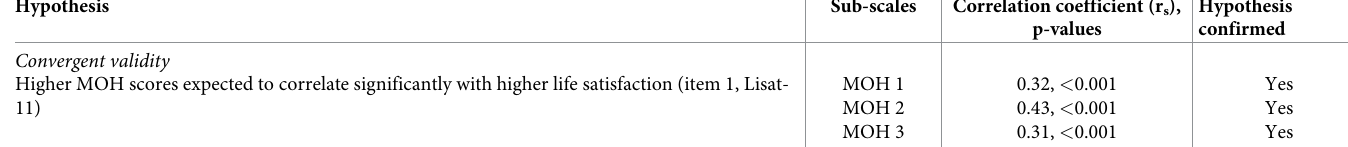
Hypothesis p-values